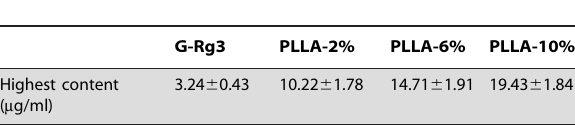
Table 3. G-Rg3 concentration after soaking pure G-Rg3 and drug loaded fibrous scaffolds in PBS